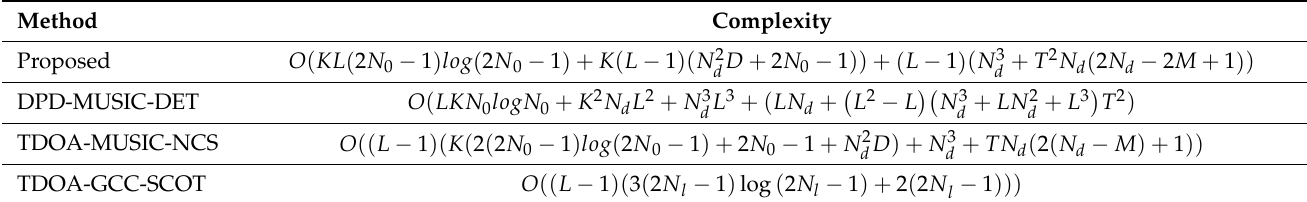
Table 1. Complexities of different